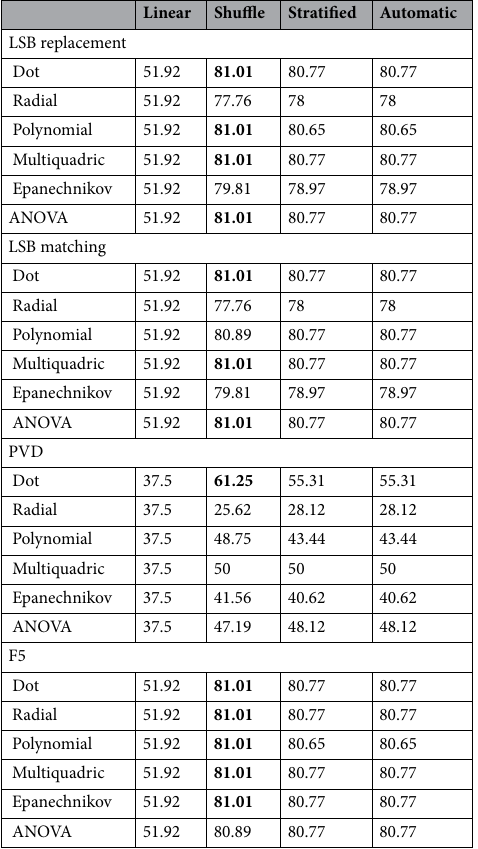
Linear Shuffle Stratified